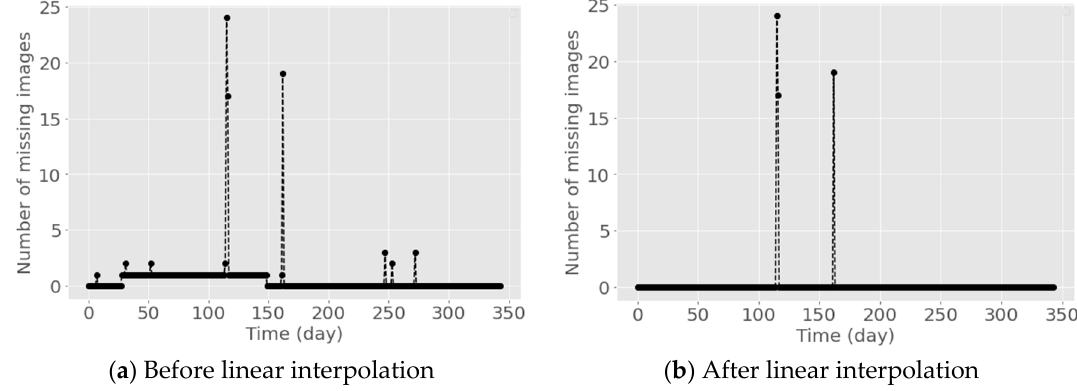
Figure 3. Number of missing images per day.